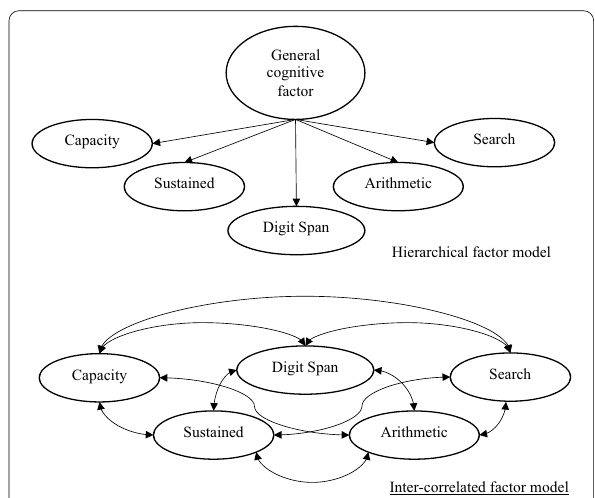
Fig. 6 Graphic depiction of hierarchical factor model with five factors and the model with five inter-correlated